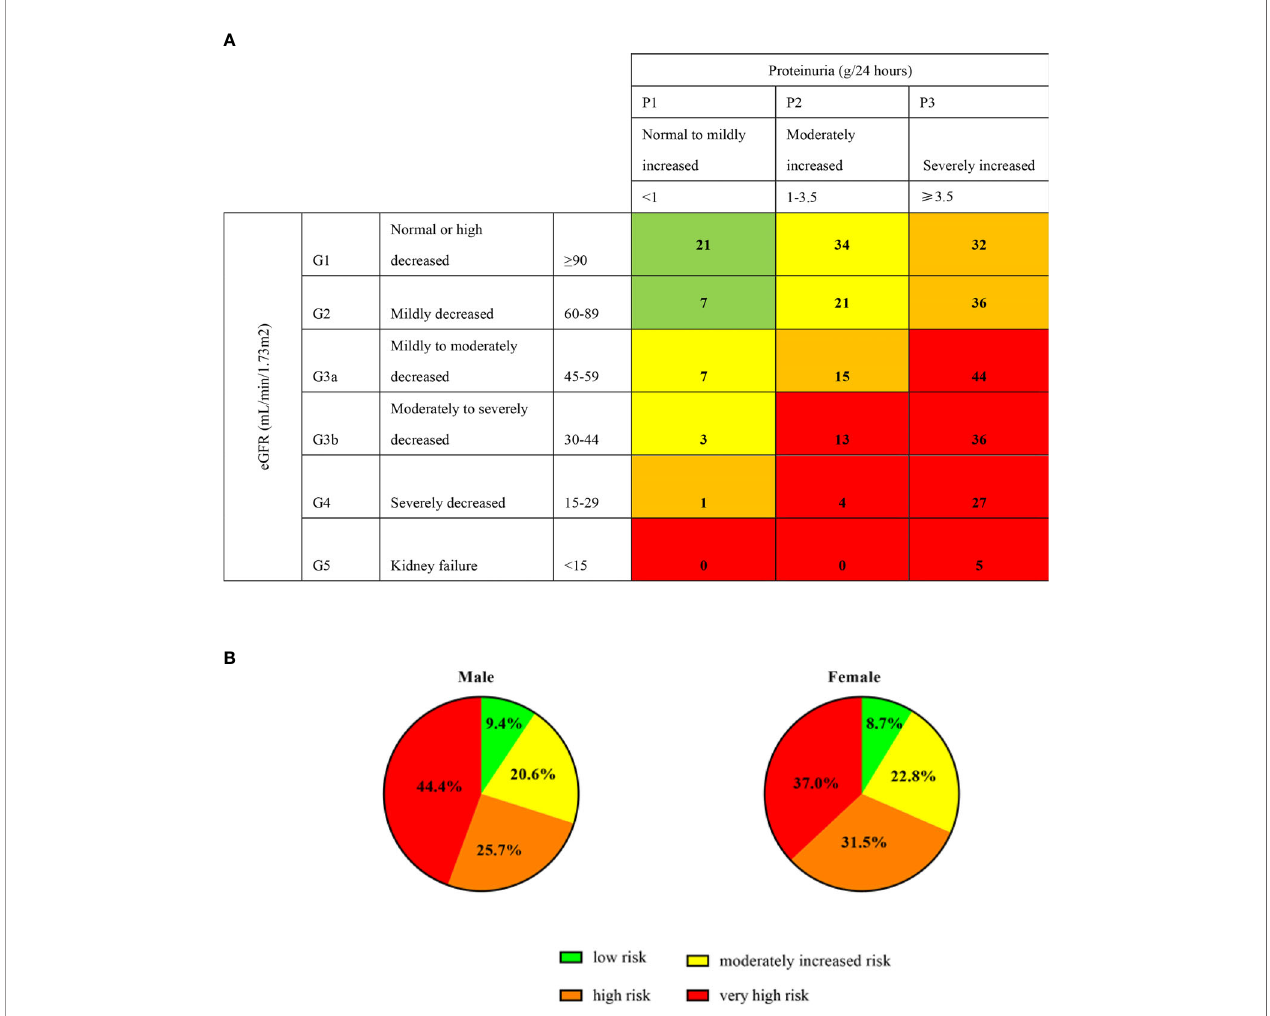
FIGURE 1 | Prognosis of CKD categories and sex. Proteinuria (g/24 hours) of 306 patients were obtained at the baseline. Green, low risk (if no other markers of kidney disease, no CKD); Yellow: moderately increased risk; Orange: high risk; Red, very high risk. The digits in (A) cells represent the numbers of patients. (B) represent the percentage of male and female in different